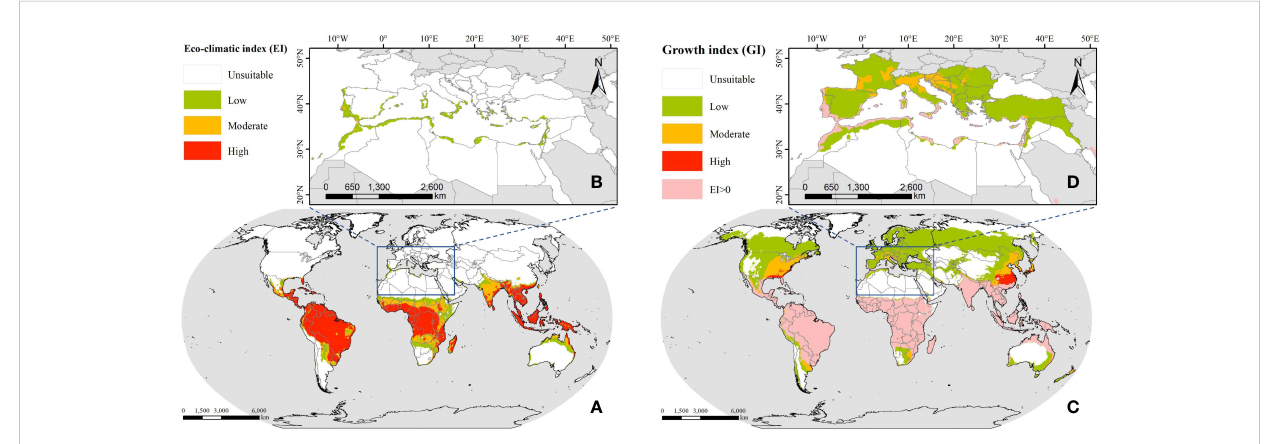
FIGURE 2 The suitable distribution of FAW predicted by CLIMEX; (A) annual suitable distribution in the world; (B) annual suitable distribution in the ROI; (C) seasonal suitable distribution in the world; (D) seasonal suitable distribution in the ROI.